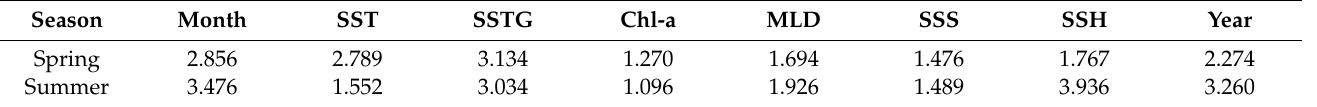
Figure 3. QQ ‐ plot of A. thazard lg (Catch) in spring and summer.